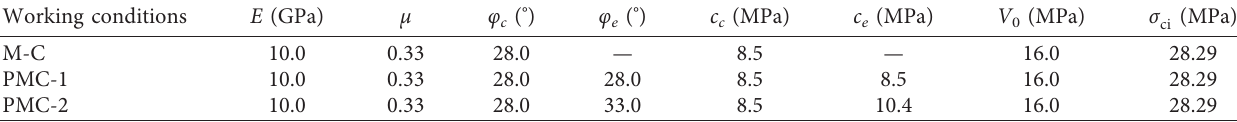
Table 3: Parameter table of the triaxial compression test model.